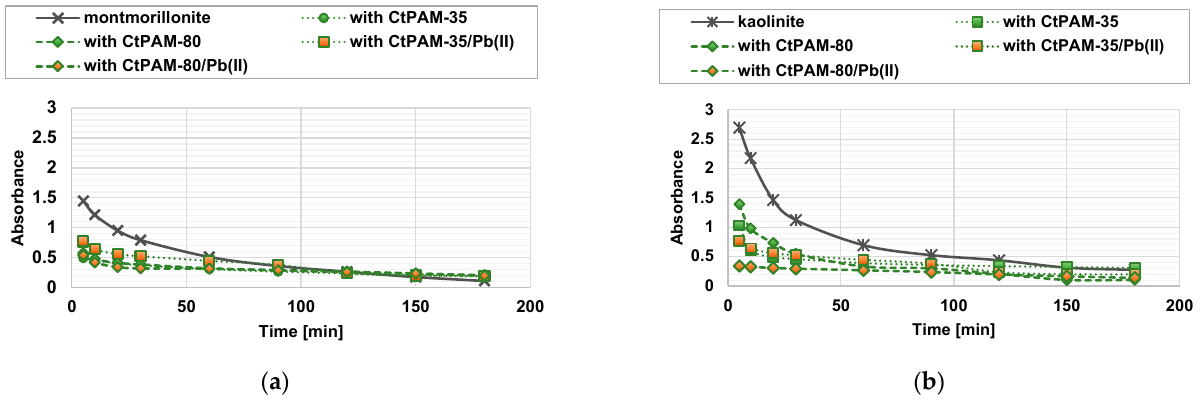
Figure 3. The influence of the presence of cationic polyacrylamide with different content of functional groups with initial concentration 100 mg/L) and Pb(II) ions (initial concentration 10 ppm) on the stability of the suspension of: ( a ) montmorillonite; ( b ) kaolinite at pH 5. The stability of montmorillonite suspension without adsorbates at pH 5 is noticeably lower than kaolinite one. The presence of cationic polyacrylamide and lead ions affects the suspension stability of both montmorillonite and kaolinite. In the systems where